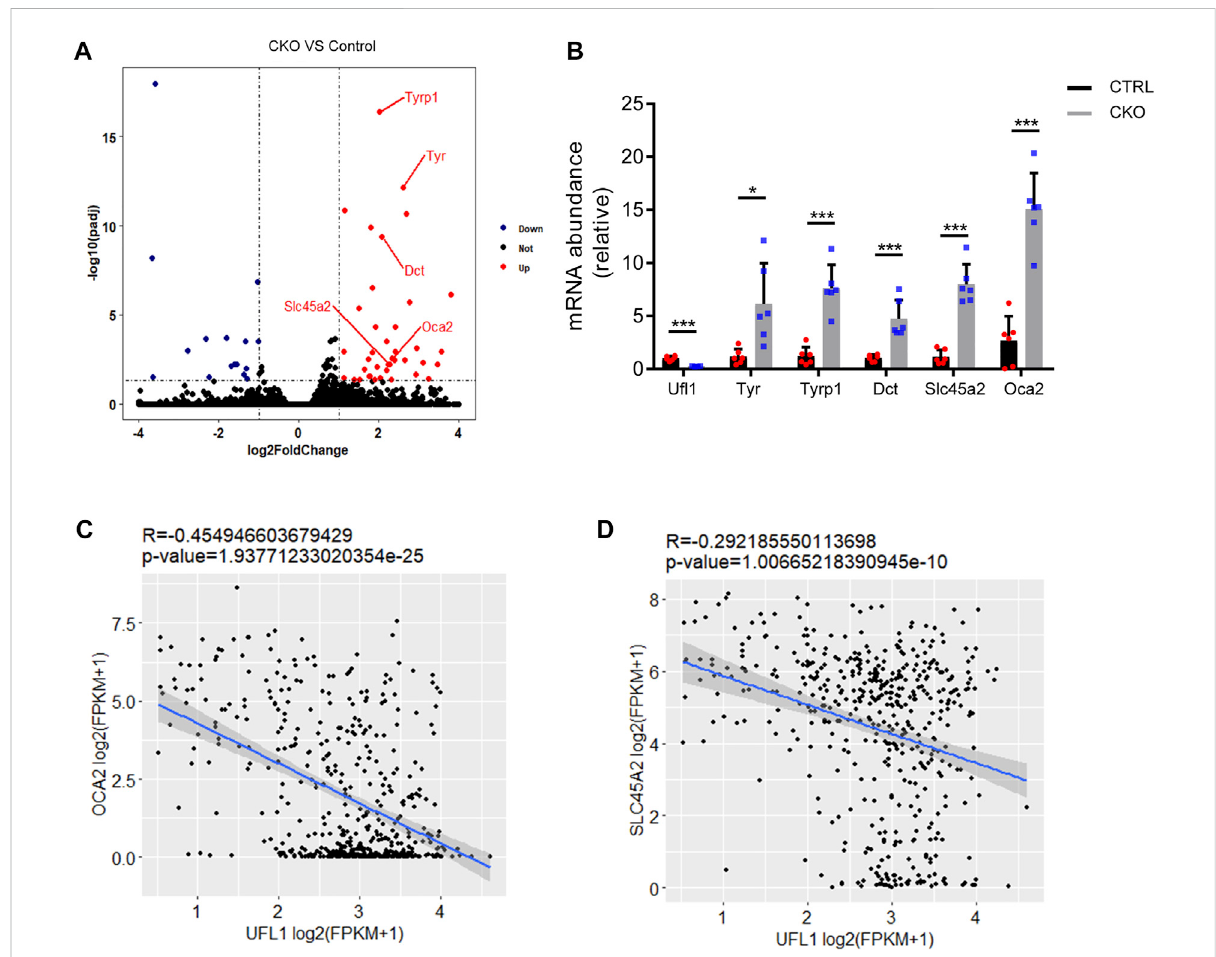
FIGURE 3 Global transcriptome analysis of ear. (A) Volcano plot of downregulated (blue) and upregulated (red) transcripts in CKO mice skin. Genes in melanin biosynthesis differentially expressed are marked by red lines. (B) q-PCR con fi rmation of mRNA expression of melanin biosynthesis- related genes. (C,D) Pearson ’ s correlation between U fl 1 and OCA2 or SLC45A2 in The Cancer Genome Atlas (TCGA) SKCM. Plots show the Spearman ’ s correlation and OCA2 or SLC45A2 with UFL1 mRNA level from RNA-seq data in TCGA melanoma calculated. R and p values are shown. * p < 0.05, *** p < 0.001, unpaired Student ’ s test. Error bars represent ±